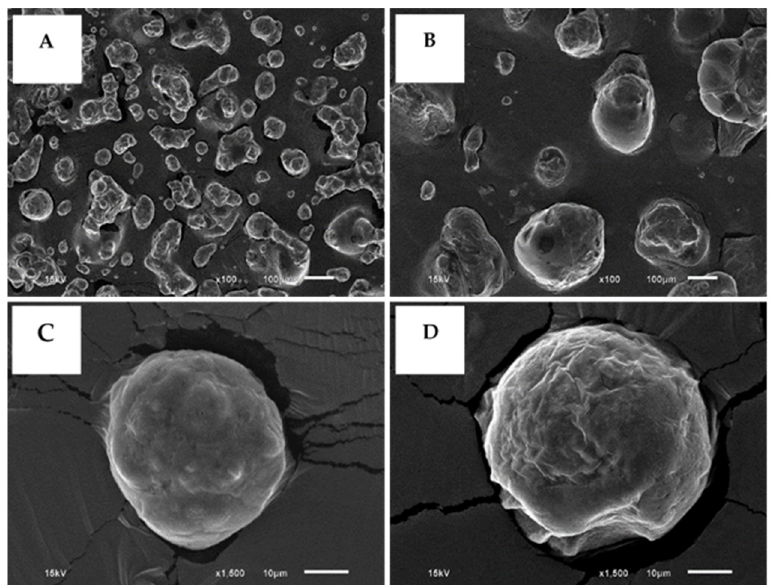
Figure 2. Micrographs of chicken breast hydrolysate powder produced by Alcalase ® and followed by Papain (CBH:A-P) that were dried with spray-drying and freeze-drying using scanning electron microscopy (SEM). Spray drying at 100× ( A ) and 1500× ( C ). Freeze-drying at 100× ( B ) and 1500× ( D ). Table 3. Antioxidant activities of the chicken breast hydrolysate powder produced by Alcalase ® and followed by Papain (CBH:A-P) under different drying conditions 1,2 .